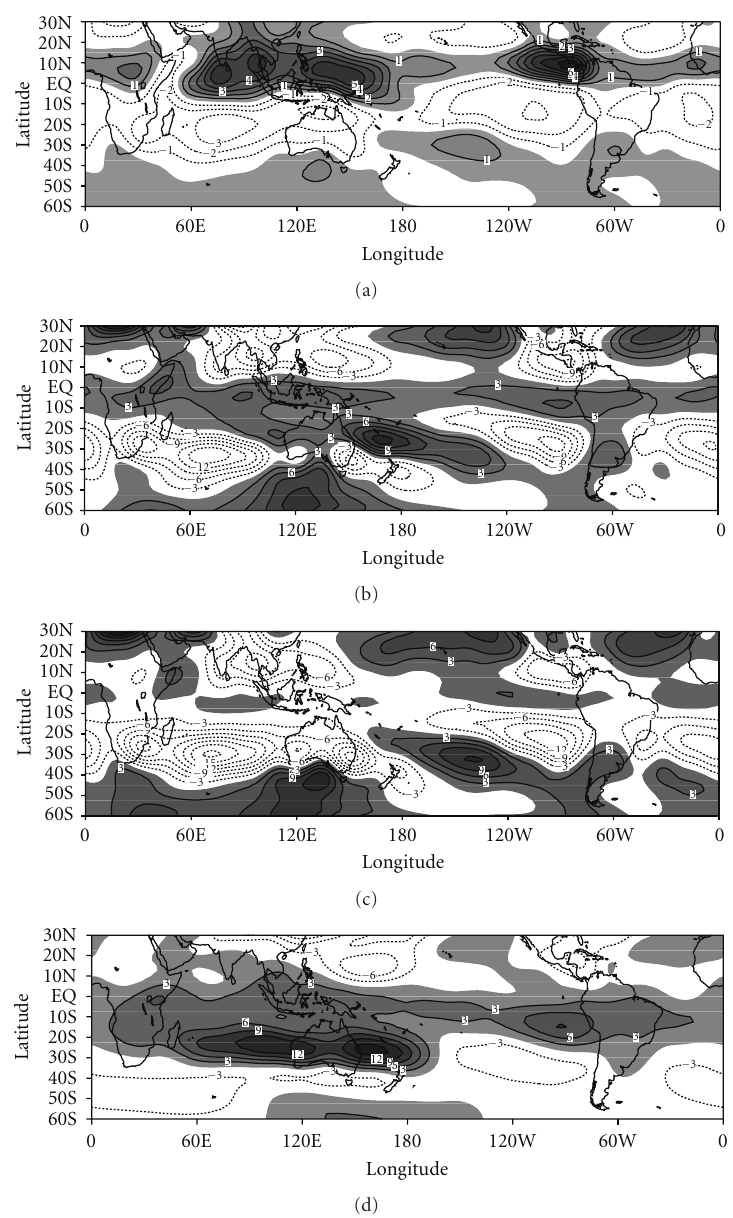
Figure 2: Climatological average (1979–2010) at 200 hPa in JJA for: (a) divergence ( × 10 − 6 s − 1 ), (b) Rossby wave source ( × 10 − 11 s − 2 ), (c) vortex stretching term ( × 10 − 11 s − 2 ), (d) advection of absolute vorticity by divergent flow term ( × 10 − 11 s − 2 ). The shaded areas represent positive values. The divergence contour plot has a contour interval of 1 × 10 − 6 s − 1 . Rossby wave source and its terms contour plots have contour interval of 3 × 10 − 11 s − 2